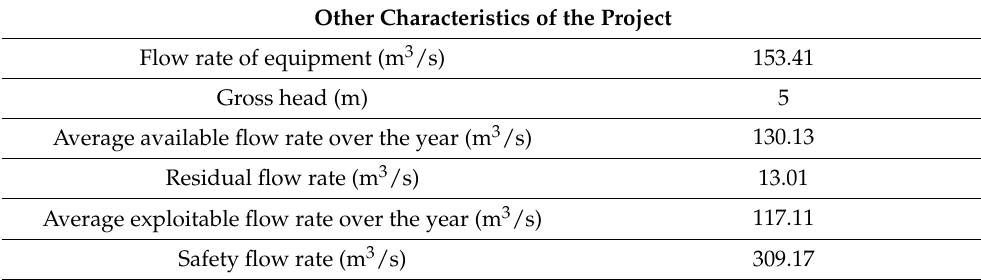
Table 13. Other characteristics of the